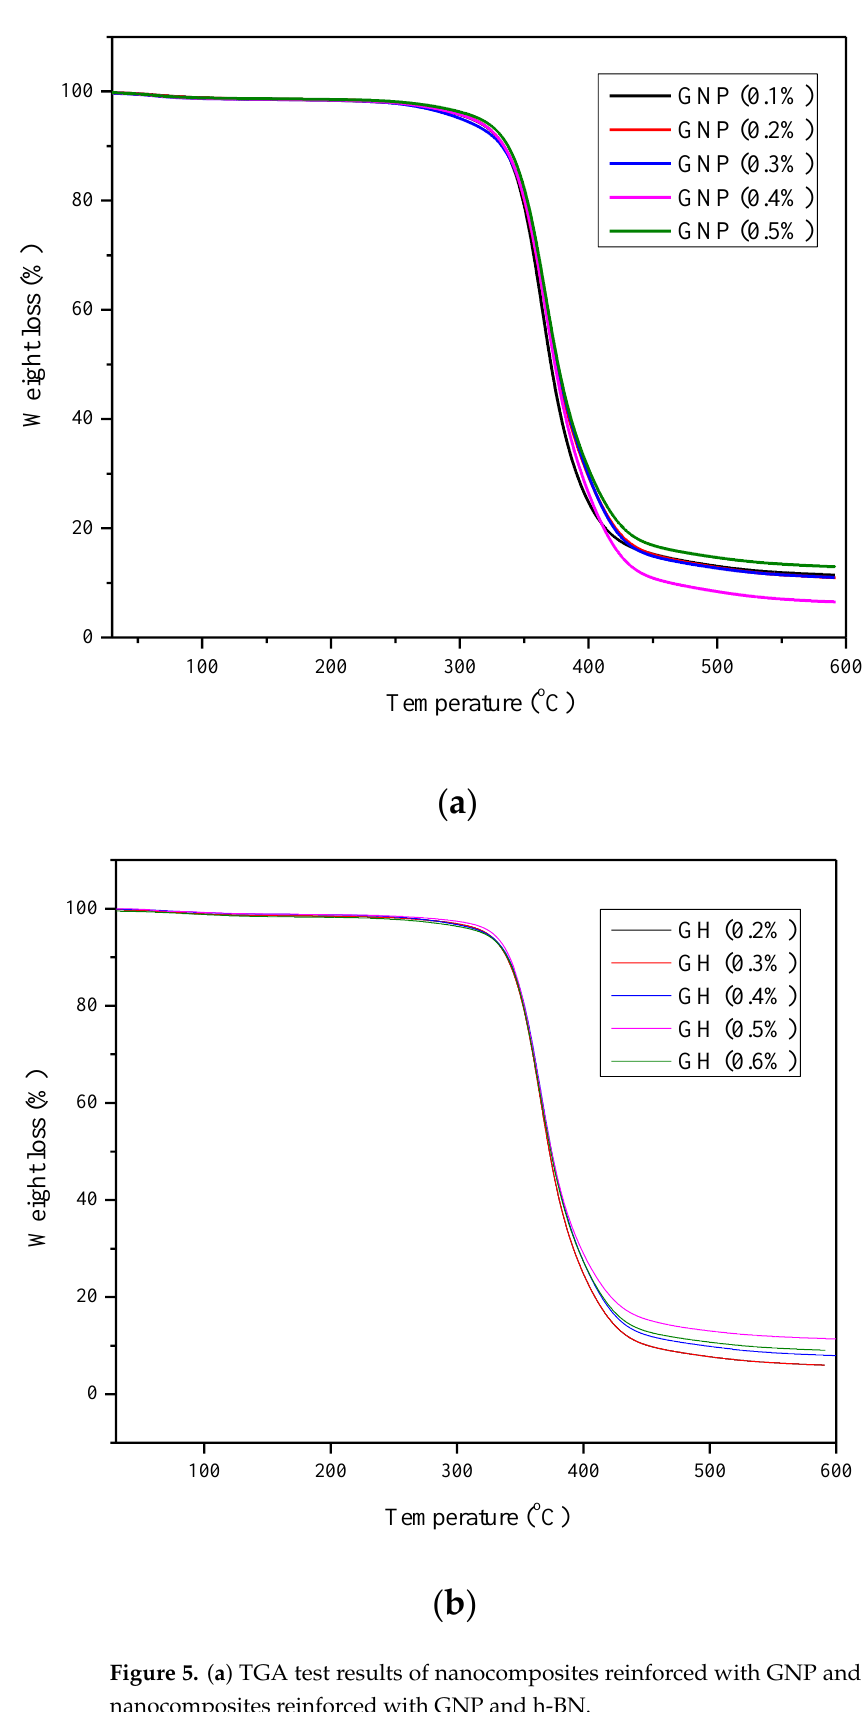
Figure 5. ( a ) TGA test results of nanocomposites reinforced with GNP and ( b ) TGA test results of nanocomposites reinforced with GNP and h-BN.